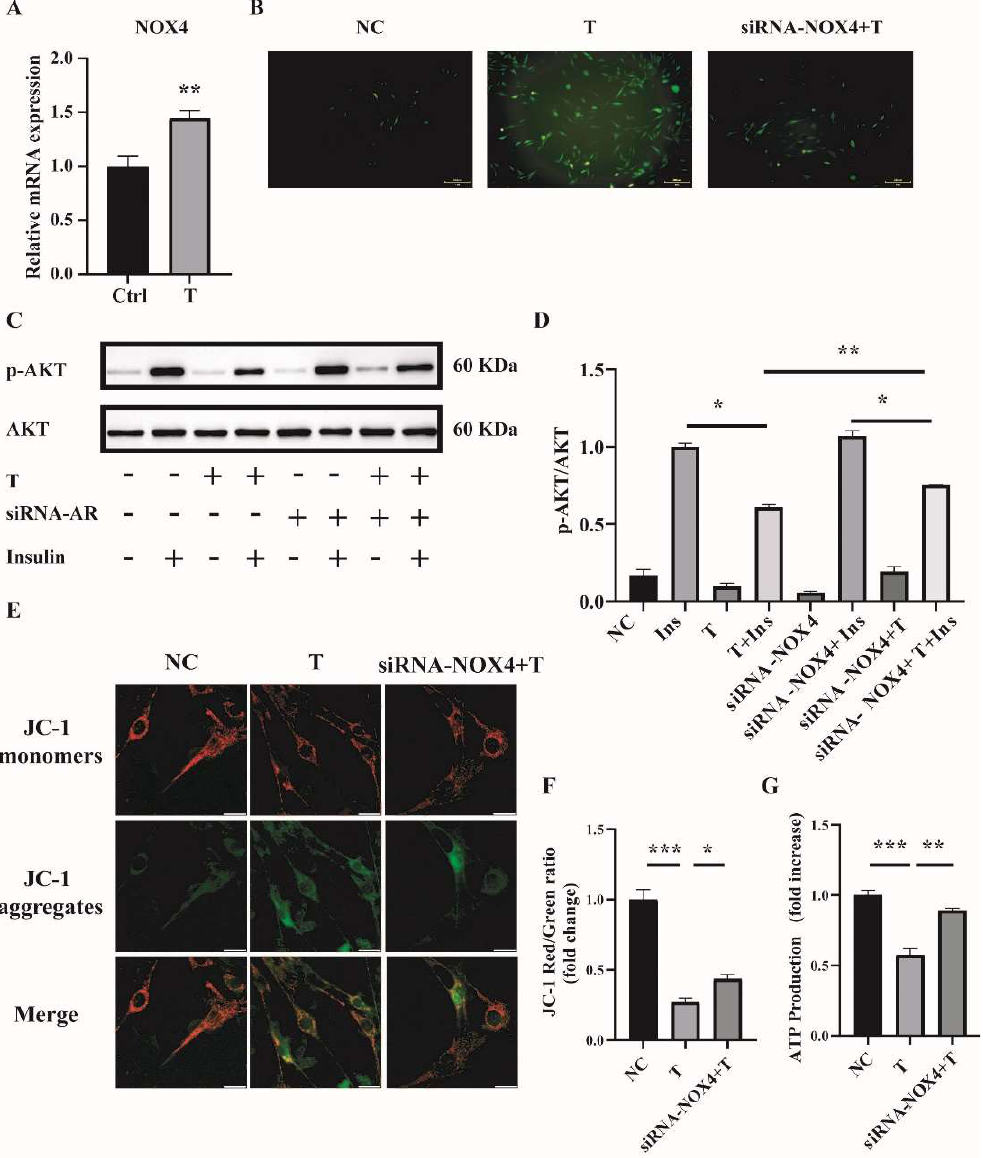
Figure 5. NOX4 expression in T-treated C2C12 cells and effects of NOX4 on mitochondrial function. ( A ) Fully differentiated C2C12 cells were treated with T (0 and 10 −5 M) for 12 h. Relative mRNA levels of NOX4 in the cells. ( B ) Representative photomicrographs of intracellular ROS in C2C12 cells. Fully differentiated C2C12 cells were transfected with siRNA-NOX4 or non-silencing RNA and then treated with T (0, 10 μM) for 12 h. Intracellular ROS levels were determined by DCFH-DA staining. Scale bar= 200 μm( C ) Insulin-signaling assay. ( D ) Densitometry quantification of pAKT/AKT of the insulin-signaling assay in C2C12 cells. ( E ) The mitochondrial membrane potential ( ∆Ψ m) was determined by JC-1. Scale bar = 25 µ m. ( F ) The ratios of JC-1 aggregate/monomer were analyzed by the Image J program. ( G ) Normalized ATP production. The data are presented as means ± SEM of three independent experiments. *, p < 0.05, **, p < 0.01, ***, p < 0.001. T, testosterone; Ins,